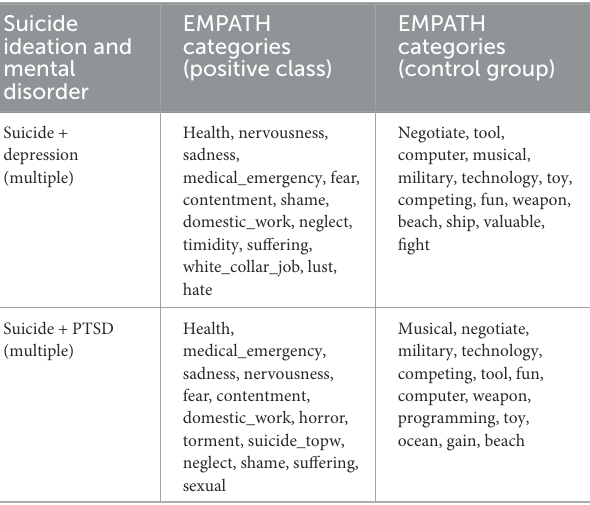
TABLE 6 Filtered EMPATH categories from combined